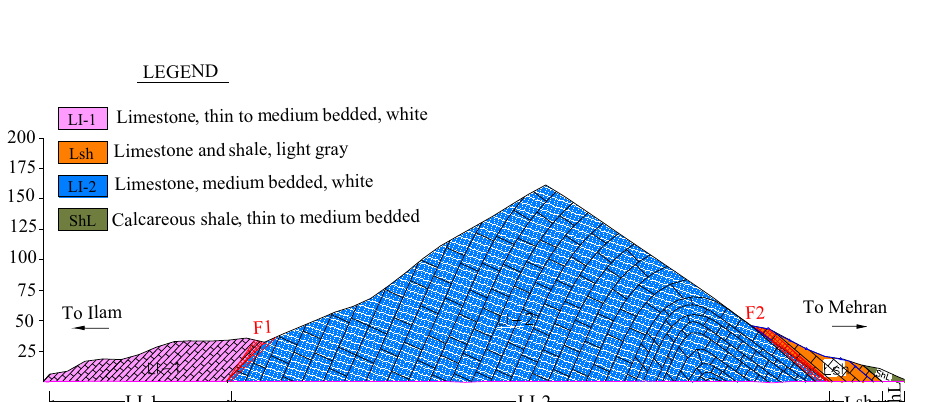
Fig. 4 Longitudinal section of Shibli tunnels